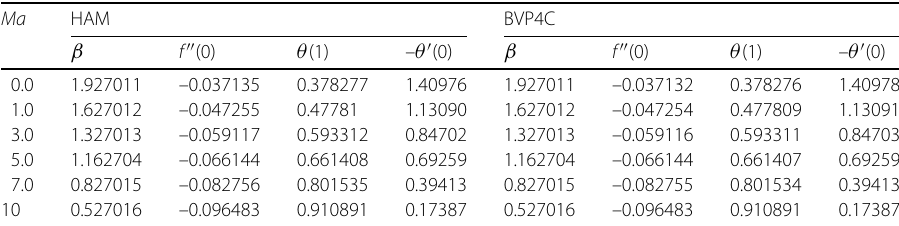
Table 8 Comparison of the values of β = Υ Mathematica package BVPh2.0 approximation and shooting method for the case β = 0.2, I 0 = 0, λ = 0.2, A = 0.3, N = 0.2, S = 0.4, Pr = 1, M = 1 and several values of Ma